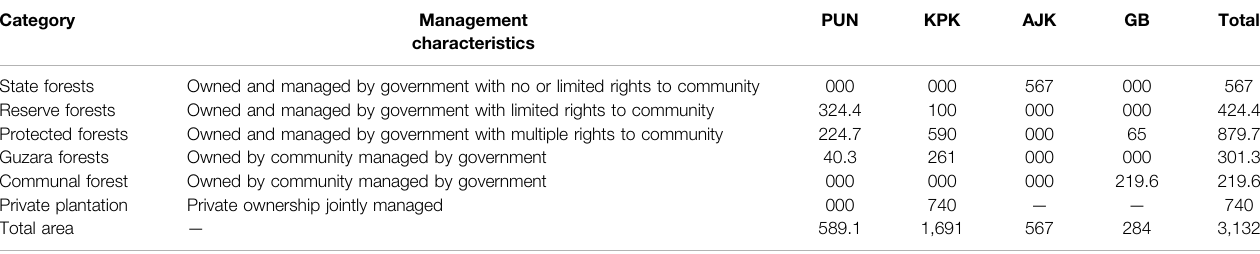
Table 1 | Categories of forests and management characteristics in the hilly areas of Pakistan (000 ha). Category